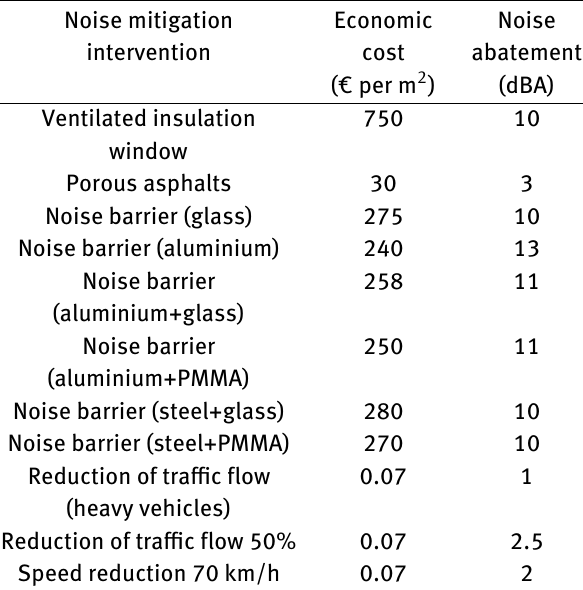
Table 3: Cost and noise abatement for each intervention